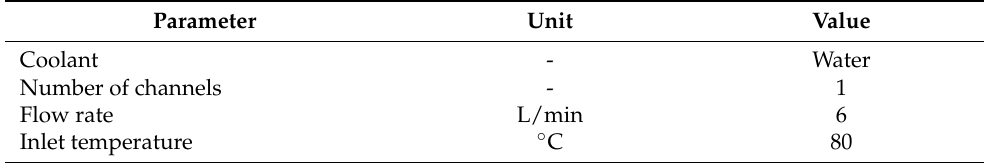
Table 2. Baseline motor thermal model parameters.